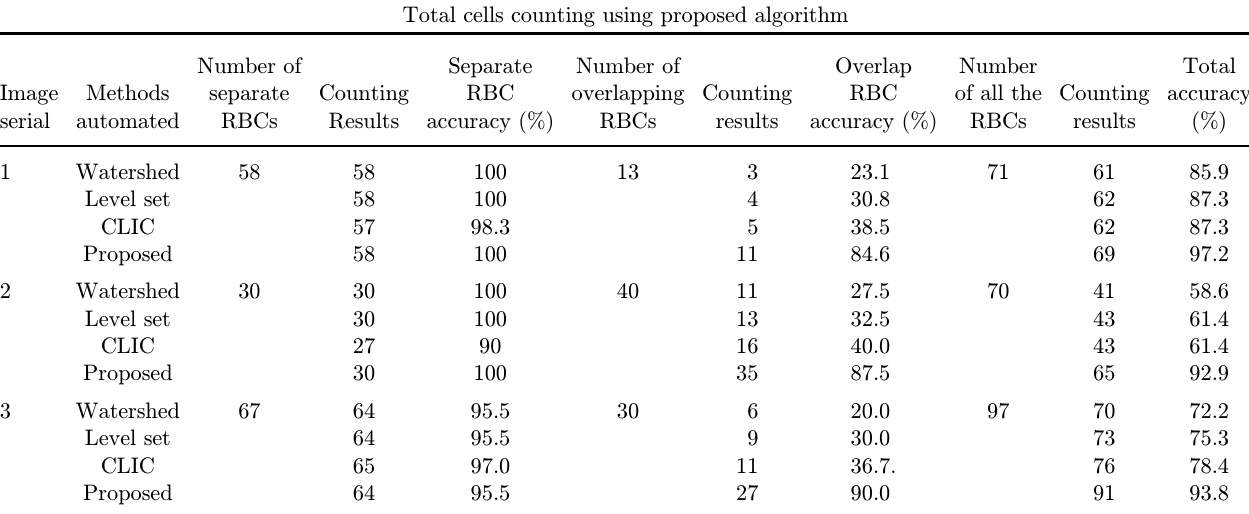
Table 2. Results by di®erent counting